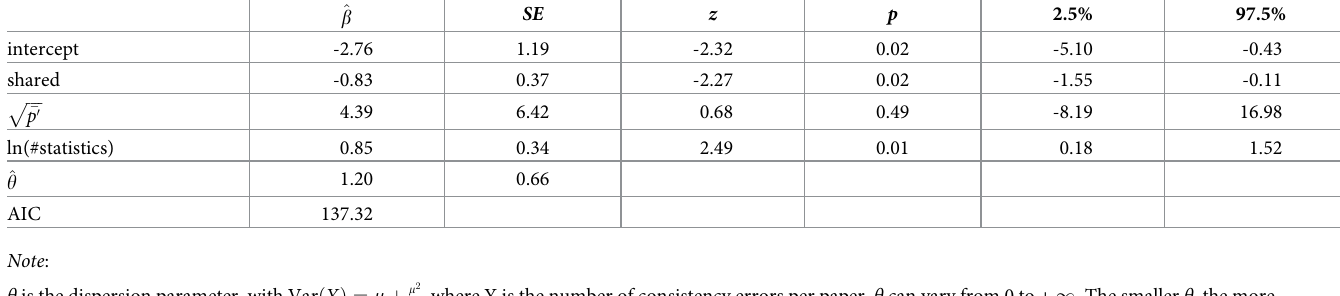
means that the expected number of consistency errors decreased by 56% when data were shared. The result of the second hypothesis was exactly reproduced in both SPSS and in R ( p = 0.015, two-tailed, Table 3 represents the contingency table).